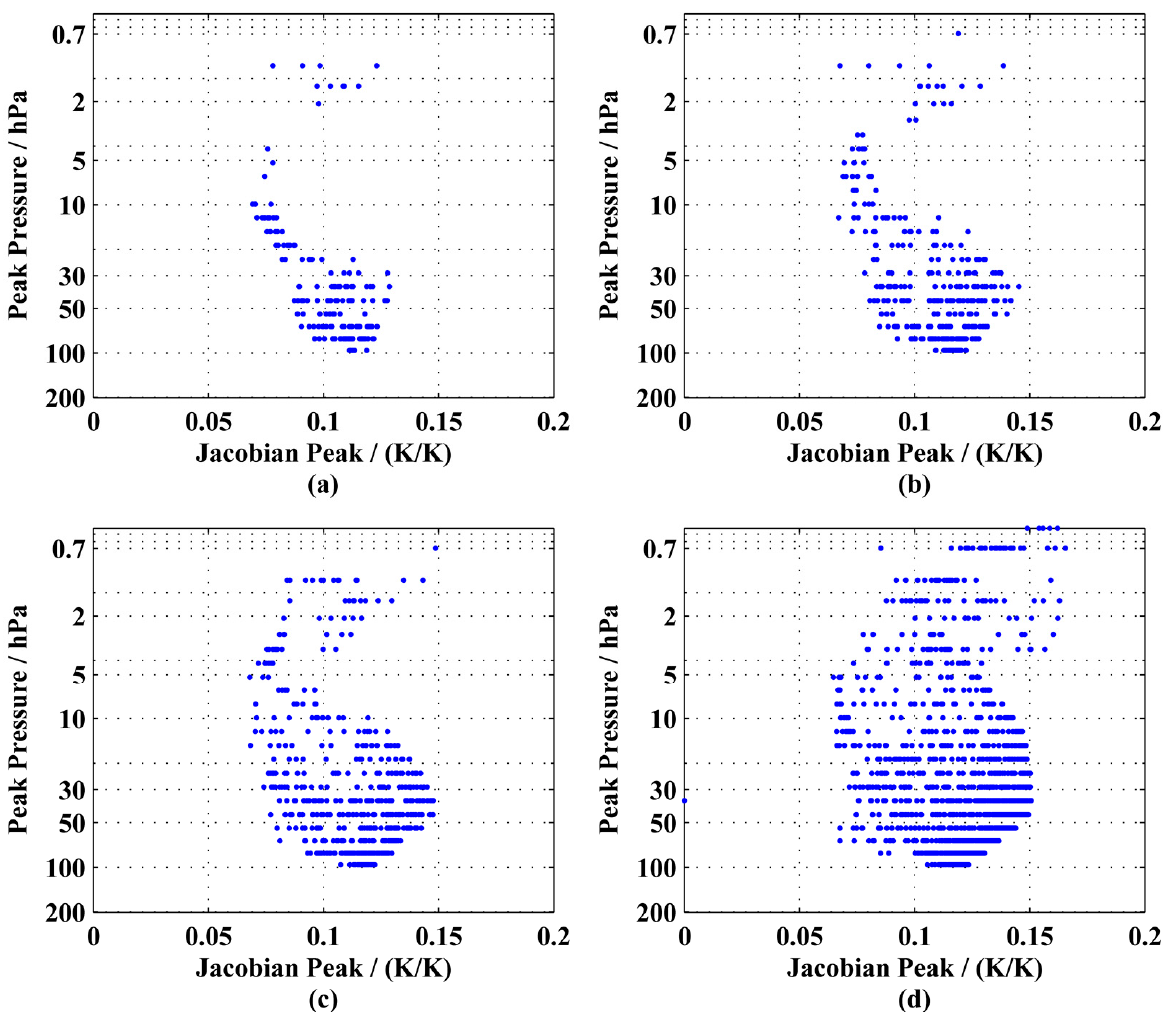
Figure 7. The temperature Jacobian peak corresponding to atmospheric pressure with different spectral resolutions and the same spectral region of 666.1–682 cm − 1 . ( a ) A spectral resolution of 0.1 cm − 1 . ( b ) A spectral resolution of 0.05 cm − 1 . ( c ) A spectral resolution of 0.03 cm − 1 . ( d ) A spectral reso- lution of 0.01 cm − 1 . (The de fi nition of the axis coordinate is the same as that of Figure 4).